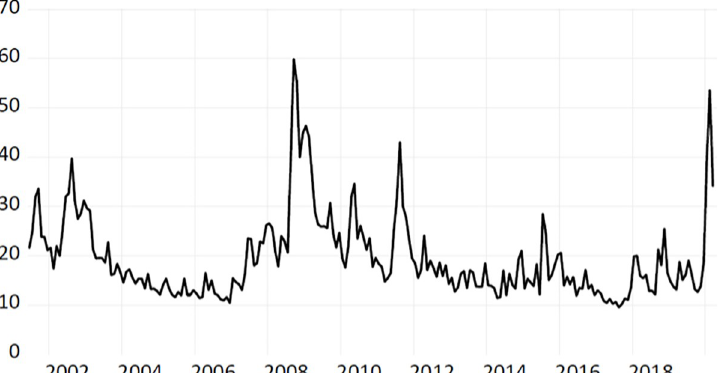
Fig 1. VIX levels and time evolution. Note: This figure depicts the time series evolution of the VIX between the years 2002–2019.